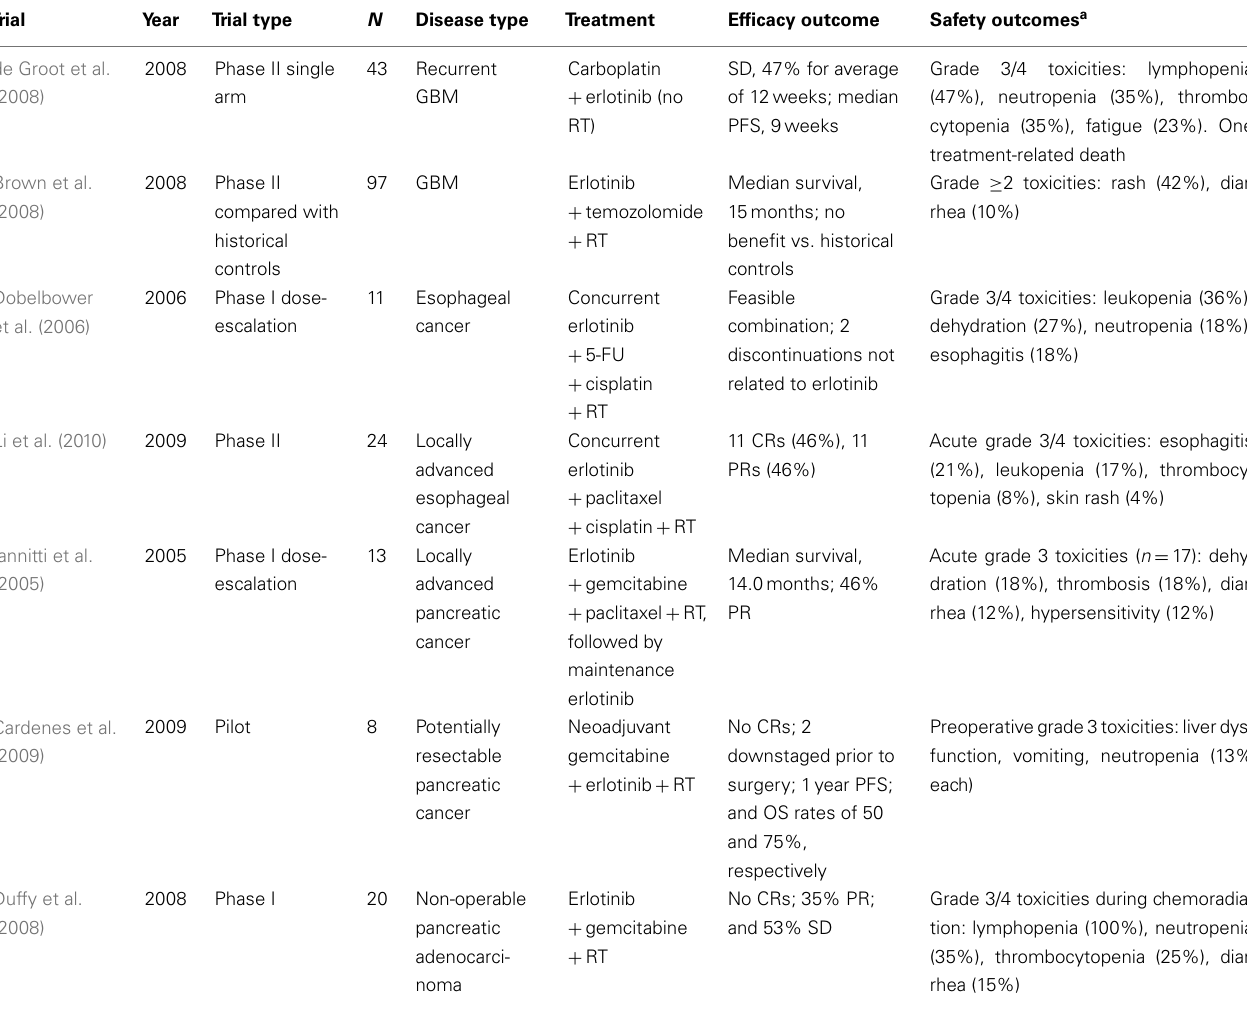
Table 3 | Recent trials of erlotinib and RT in GBM, esophageal cancer, and pancreatic cancer.